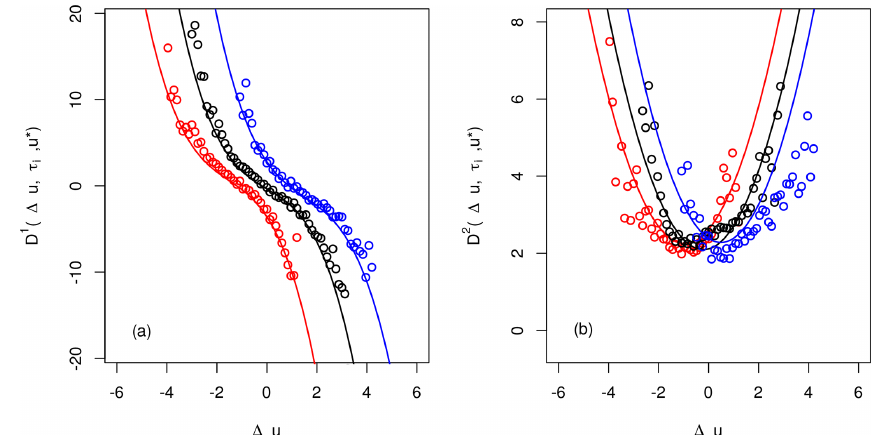
Figure 3. Exemplary estimations of the drift and diffusion functions D (1) ( (cid:49)u,τ i ,u ∗ ) and D (2) ( (cid:49)u,τ i ,u ∗ ) for τ = 65s and u ∗ ≈ − 1 . 58 (red), ≈ 0 (black) and ≈ 1 . 58 (blue). Fits for D (1) and D (2) were achieved by applying Eqs. (12) and (13).